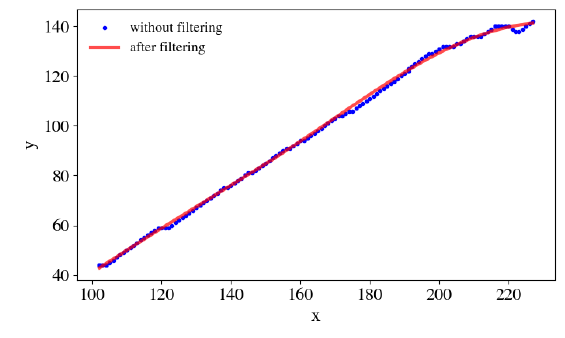
Figure 15. Path before and after filtering for Figure